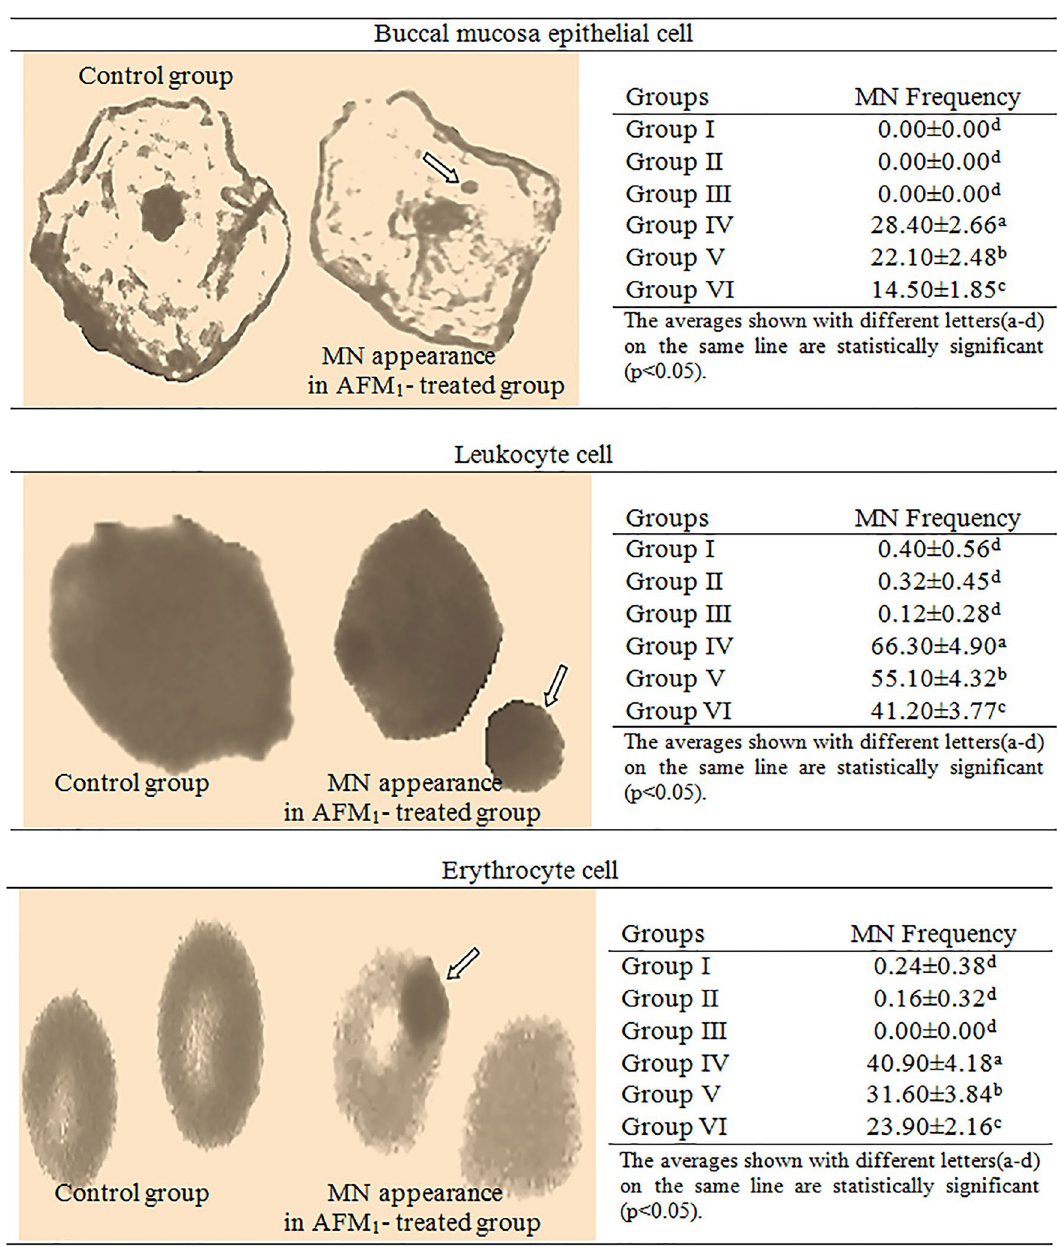
Figure 4. MN formation induced by AFM 1 . 1000 cells in each group were analyzed for MN frequency.